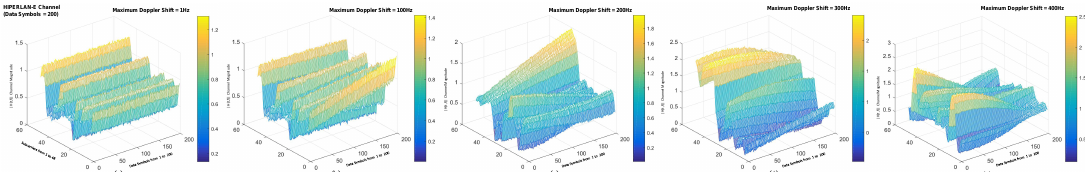
Figure 13. Impact of f d on the channel conditions. ( a ) f d = 1 Hz, ( b ) f d = 100 Hz, ( c ) f d = 200 Hz, ( d ) f d = 300 Hz, and ( e ) f d = 400